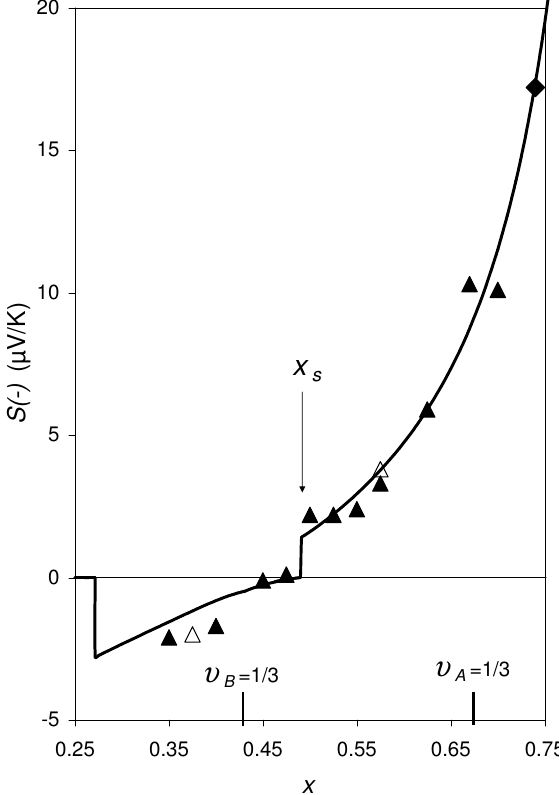
Figure 1. S ( − ) vs. x for a -Cr 1 − x Si x at T = 300 K calculated by Equation (1), respective Equation (9) and Equations (2)–(13) for the phases A (= a -Cr 3 Si) and B (= a -Si), where ∂ E C , A / ∂ T = ∂ E V , B / ∂ T = 0 was set. This curve agrees with those of Figure A.2 in [10] for c = 2.6 eV. The experimental data are taken from Gladun et al. [11] (diamonds), Weser [1] (open triangles) and Sonntag [2] (full triangles). The discontinuity in S ( − ) at x = x s = 0.49 corresponds to the discontinuities in Figures